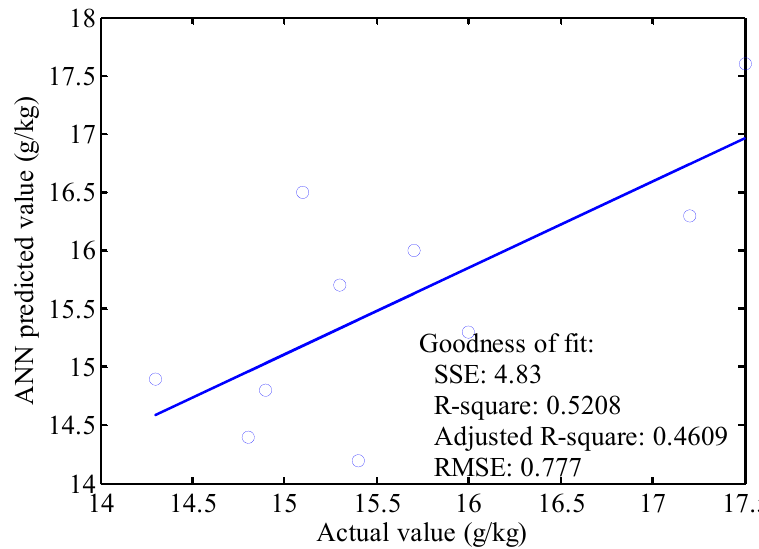
Figure 8. Testing model verification during maturity.